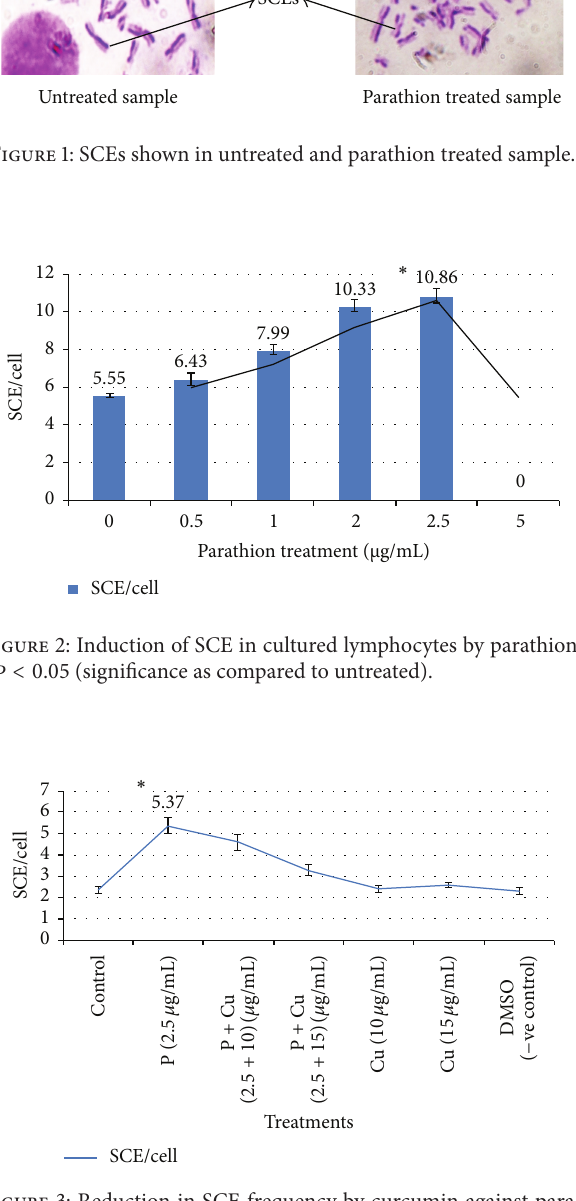
Figure 3: Reduction in SCE frequency by curcumin against para- thion treated cultured human lymphocytes. ∗ 𝑃 < 0.05 (significance as compared to untreated); P: parathion, Cu: curcumin, and DMSO: dimethyl